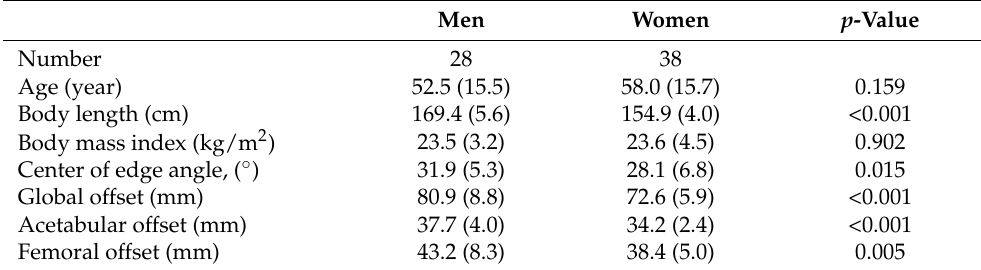
Table 1. Patient characteristics and radiographic parameters.